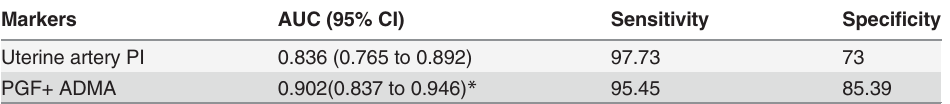
Table 4. Areas under the curves (AUC), sensitivity and specificity of second trimester uterine artery PI for prediction of preeclampsia. Markers AUC (95% CI) Sensitivity Speci fi city Uterine artery